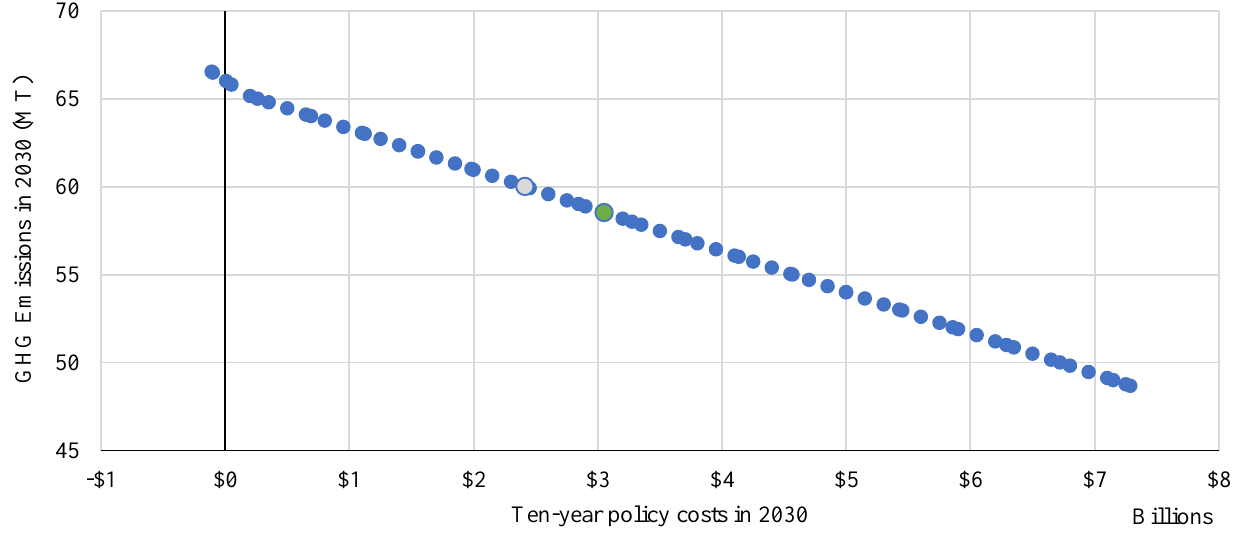
Figure A2. Pareto front 2 calculated from the MIO model. Assumes LDV fleet is 38% EV in 2030 (high-EV) and lower-bound TCO (low-TCO). Green and grey points represent the two policy scenarios (~3$ billion ten-year policy costs in 2030 and 40% GHG reduction relative to 2005 levels in year 2030) presented in Section 4.